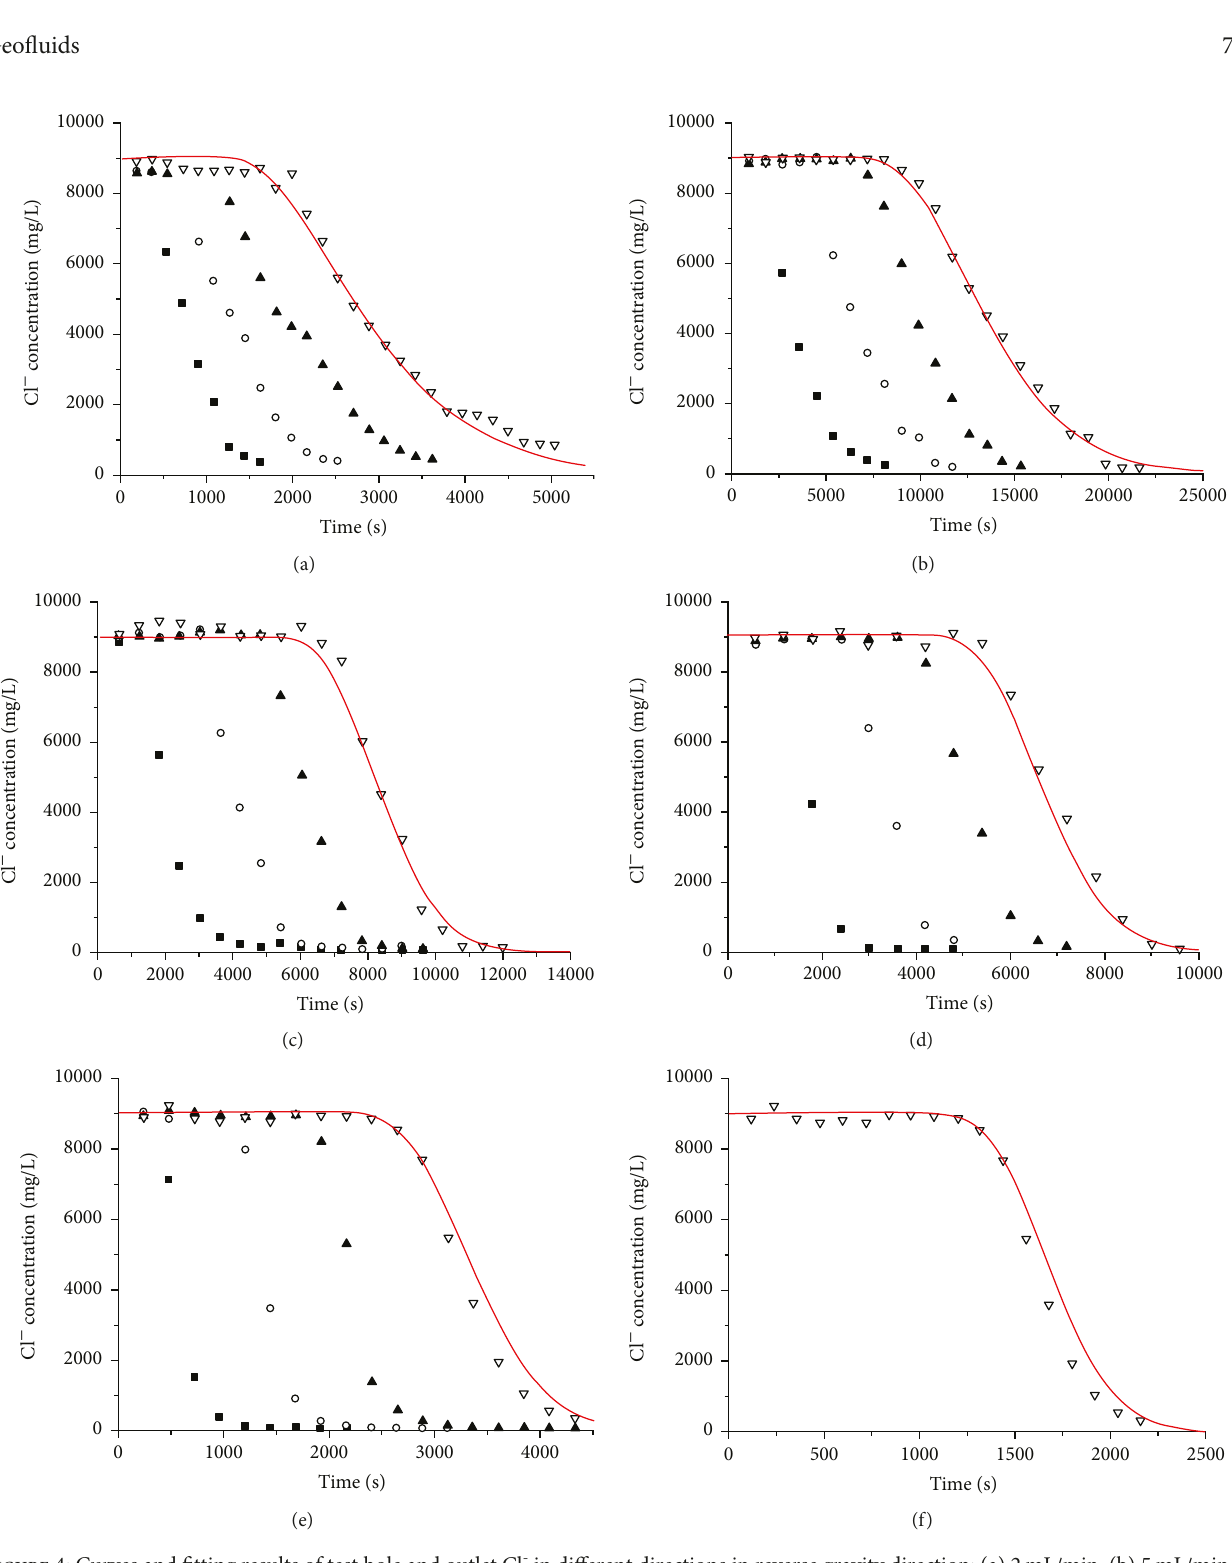
Figure 4: Curves and fi tting results of test hole and outlet Cl - in di ff erent directions in reverse gravity direction: (a) 2mL/min, (b) 5mL/min, (c) 8mL/min, (d) 10mL/min, (e) 20mL/min, and (f) 40 mL/min. ■ : monitoring hole A; ○ : monitoring hole B; ▲ : monitoring hole C; ∇ : outlet; — : analog